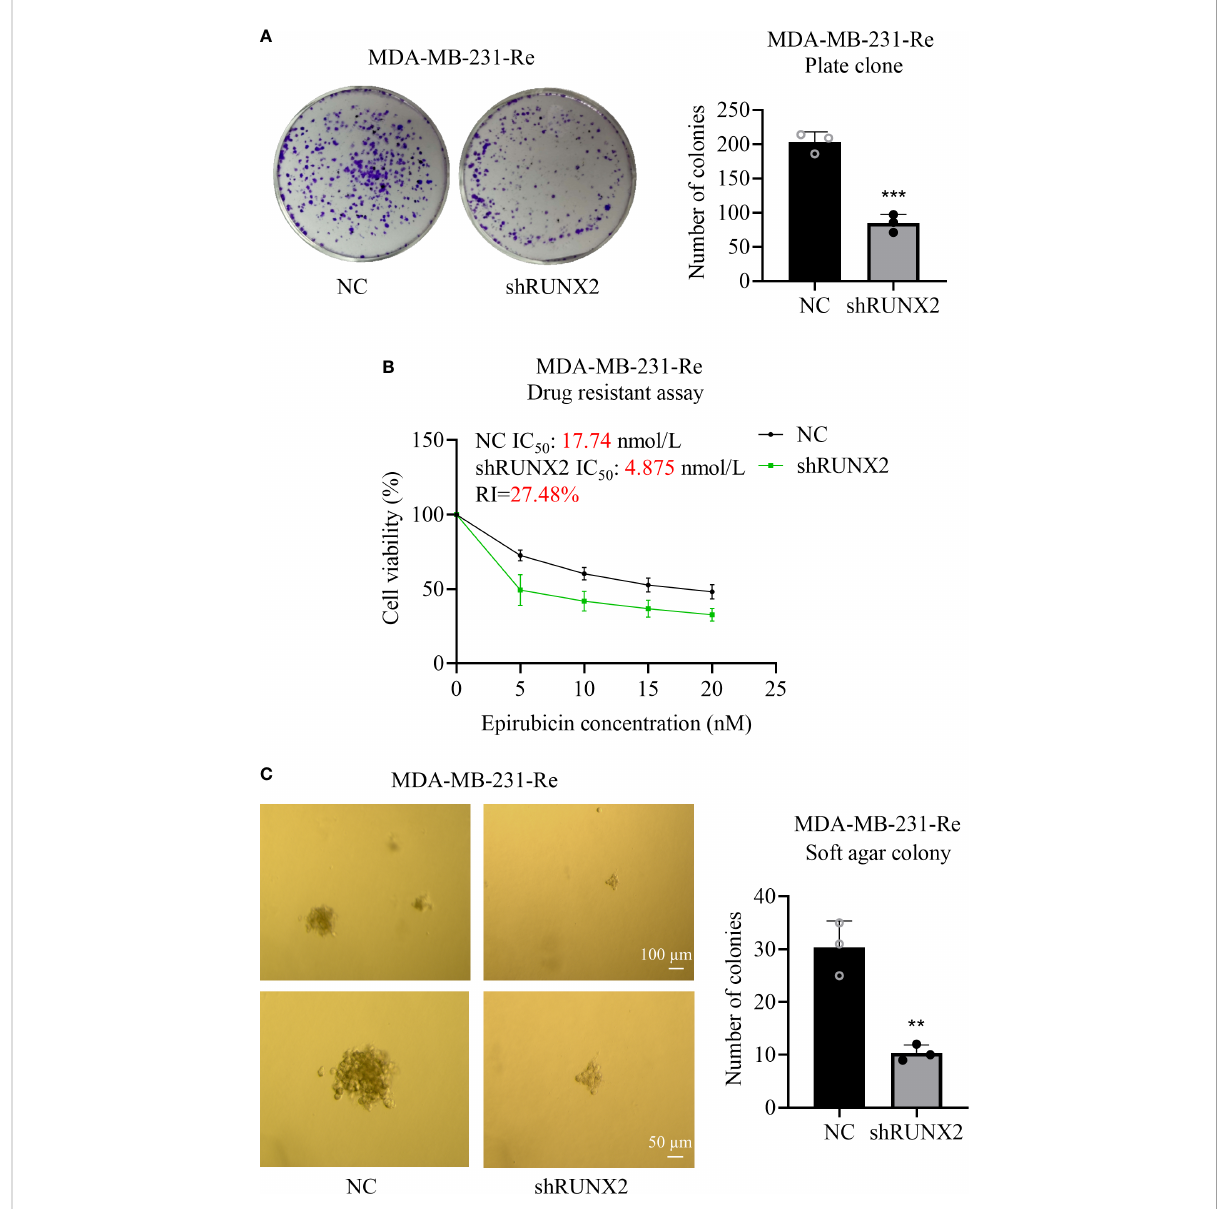
FIGURE 3 In fl uence of RUNX2 on the proliferation and resistance of drug-resistant cells in breast cancer. (A) Proliferative capacity of the shRUNX2 and NC MDA-MB-231-Re cells was determined by plate cloning assay. (B) Resistance to the shRUNX2 and NC MDA-MB-231-Re cells was determined by the CCK-8 assay. (C) The anchorage-independent growth capacity of the shRUNX2 and NC MDA-MB-231-Re cells was determined by a soft agar colony formation assay. Scale bar =100 µm, 50 µm. All data were shown as mean ± SD (N=3 independent experiments). **P<0.01;